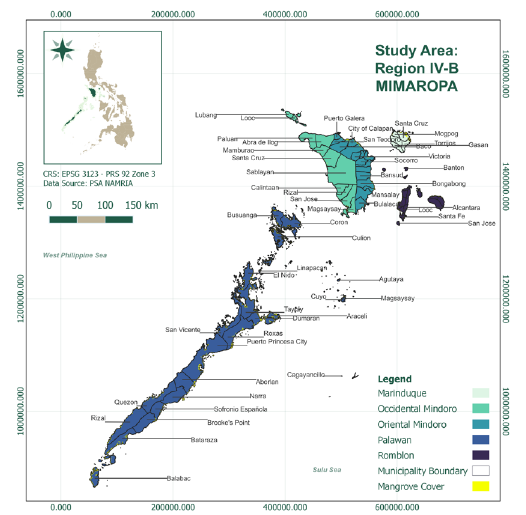
Figure 1. Region IV-B Administrative Boundaries